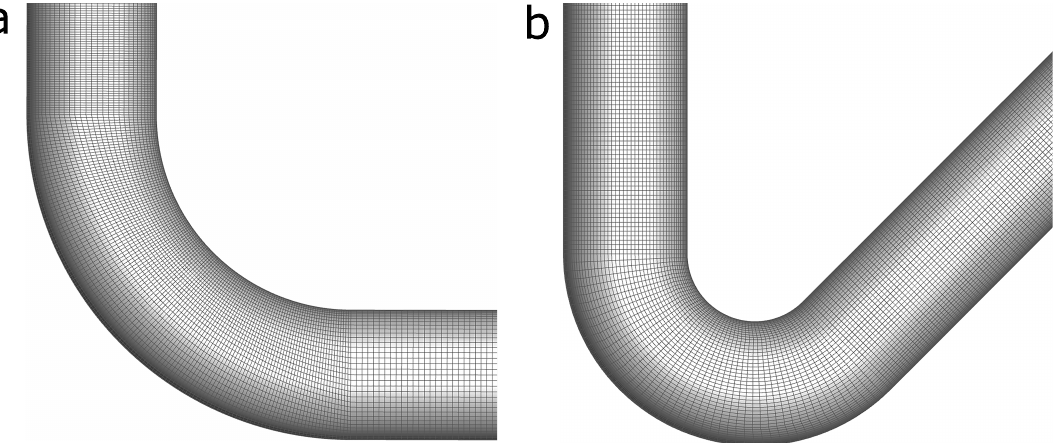
Figure 1. Structured meshes of the two channels with different curvature ratios: ( a ) Mesh of 90° channel; ( b ) Mesh of 45° channel.